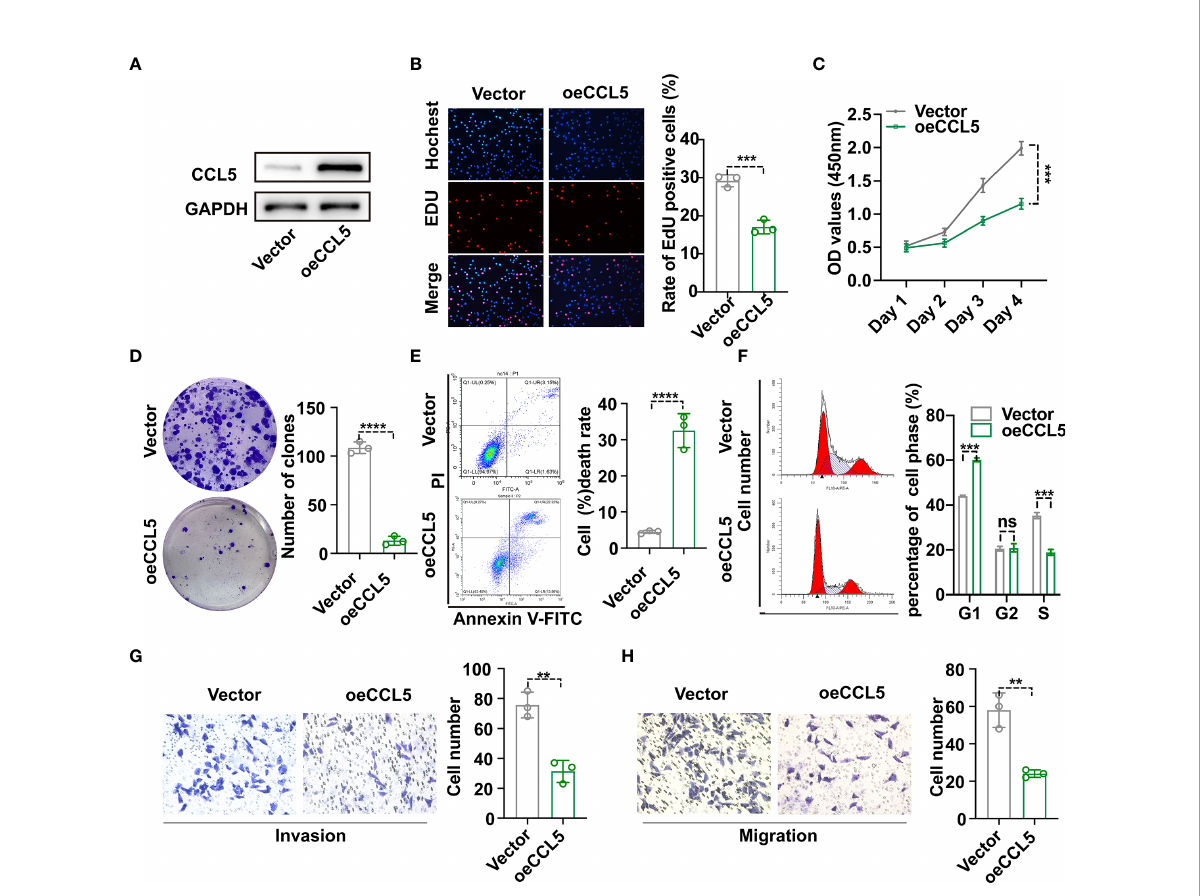
FIGURE 8 (A) Construction of CCL5 over-expressed stable MDA-MB-231 cell line and veri fi cation via western blot analysis. The proliferation and clonogenic capacity of MDA-MB-231/oe- CCL5 cells and MDA-MB-231/Vector cells were examined via EdU assay (B) , Cell Counting Kit-8 assay (C) and Colony formation assay (D) . Flow cytometric analysis combining with Annexin V-FITC/PI staining (E) and PI staining (F) were used to assess cell apoptosis rate and cell cycle arrest state. The effect of up-regulated CCL5 on breast cancer cell invasion (G) and migration (H) based on transwell assays. oe- CCL5 cells: CCL5 over-expressed cells; **p < 0.01, ***p < 0.001, ****p <